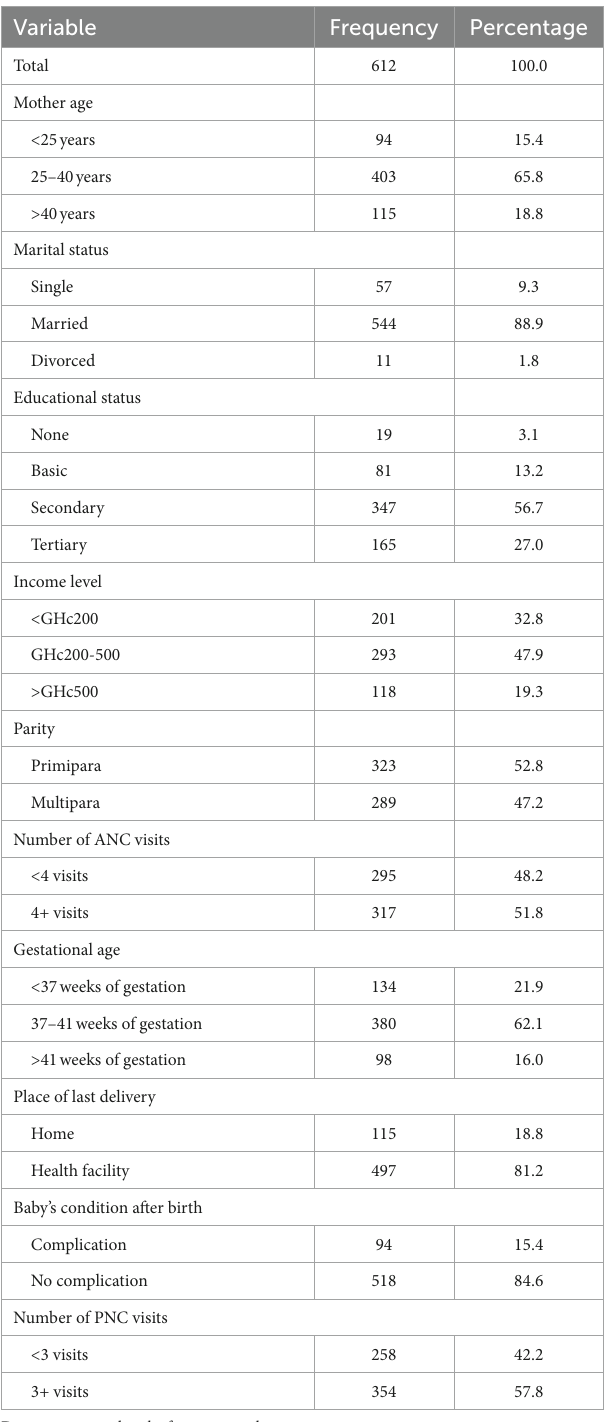
TABLE 1 Sociodemographic characteristics and reproductive health factors of mothers ( n =